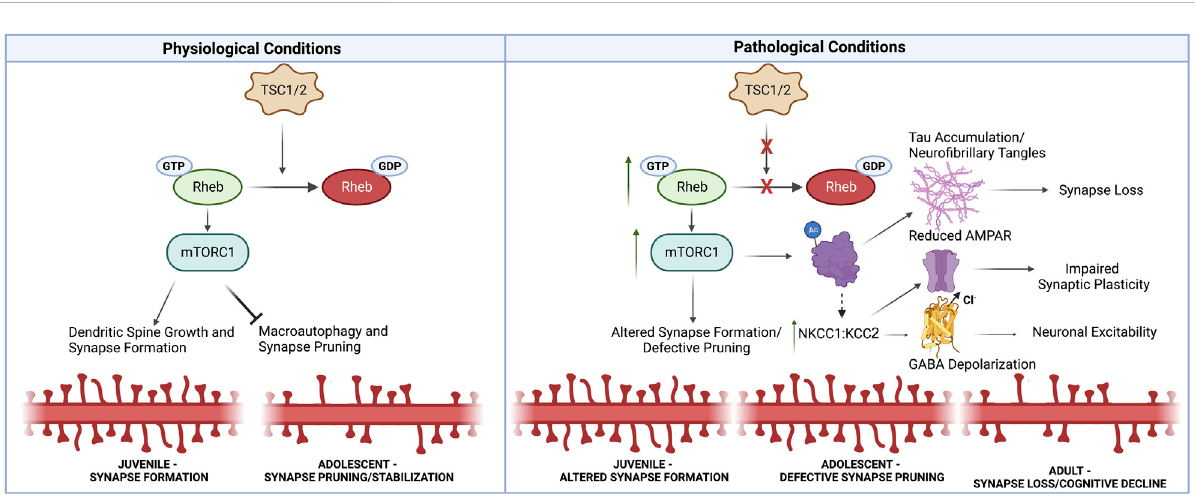
FIGURE 1 Synaptic Alterations Linking Neurodevelopmental and Neurodegenerative Pathology in TS. Under physiological conditions, TSC1/2 inhibit mTORC1 activity through Rheb-GTPase. mTORC1 promotes synapse formation, but prevents macroautophagy-mediated synaptic pruning later in development. Thus under pathological conditions in TS, mTORC1 activity is increased, resulting in defective synaptic pruning in adolescence. Increased mTORC1 also promotes tau aggregation through acetylation and phosphorylation. Furthermore, impaired autophagy prevents the clearance of tau aggregates, ultimately driving synapse loss. Additionally, TS patients exhibit alterations in NKCC1:KCC2 that resemble